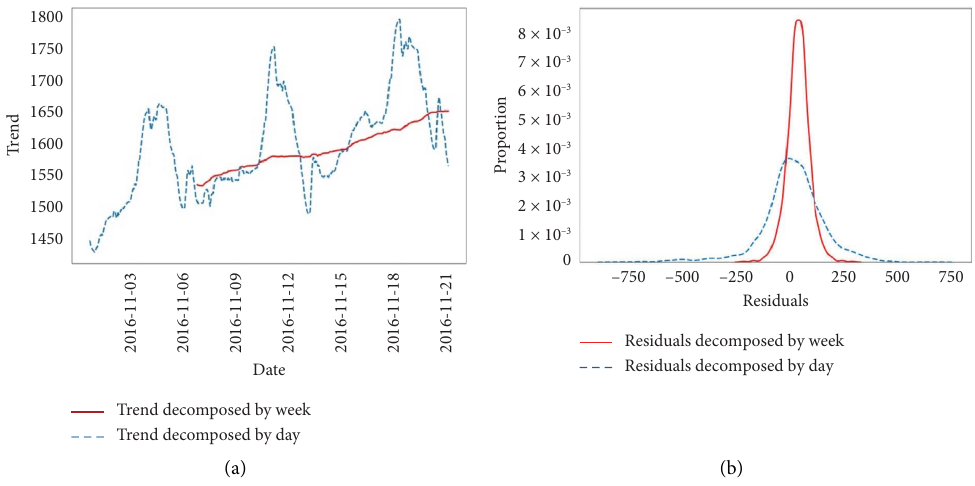
Figure 3: Temporal dependencies of demand data. (a) Trend term. (b) Residual